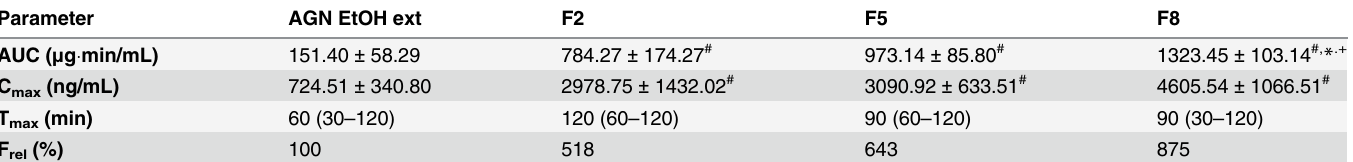
Table 6. Pharmacokinetic parameters of DOH after oral administration of AGN EtOH extract, F2, F5, and F8 in rats (n = 3 – 5).